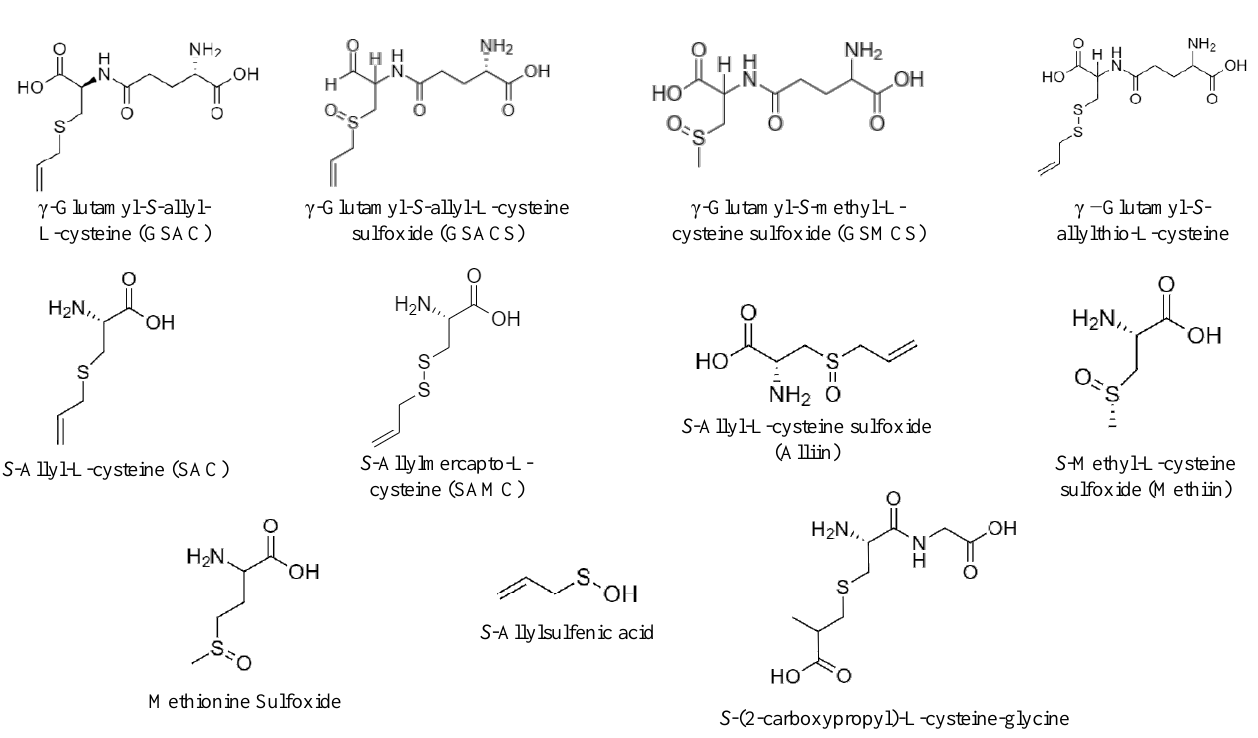
Figure 1. Chemical structures of organosulfur compounds identified in black garlic in more than 1% of the total organosulfur compounds.